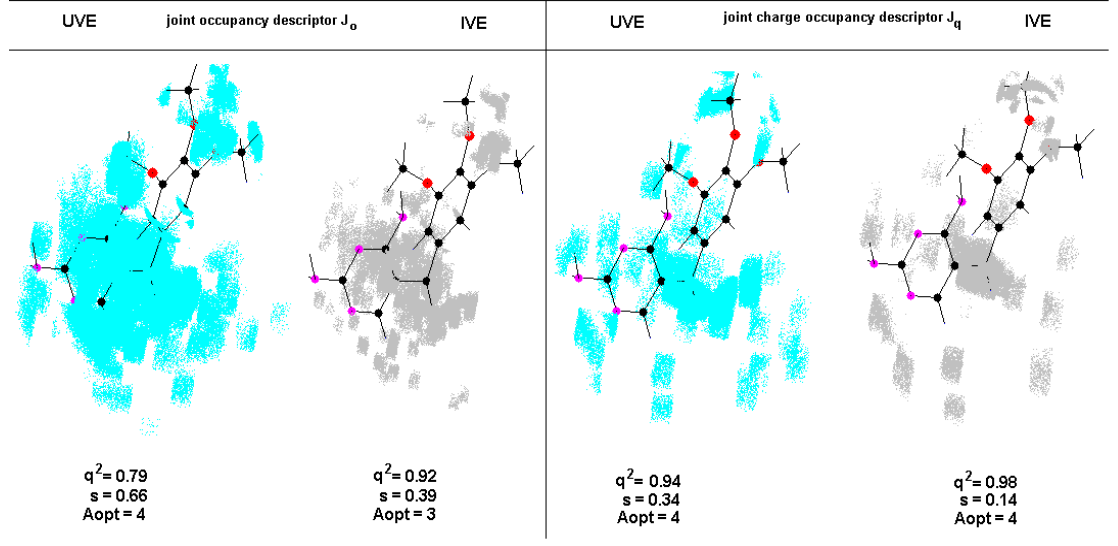
Figure 1. The 4D QSAR models of the DRI series, performed using the occupancy and charge type IPEs. The numbers indicate the q 2 and s performances, and optimal number of the PLS latent variables included in the model; after UVE and (modified procedure [11]) IVE data elimination, respectively